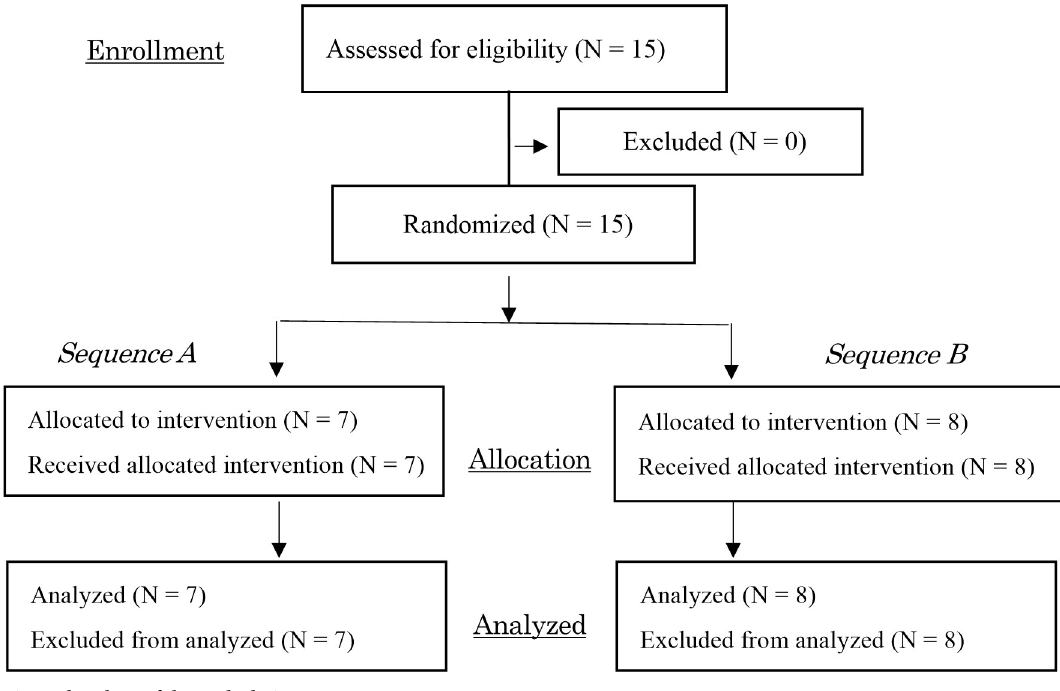
Fig 1. Flowchart of the study